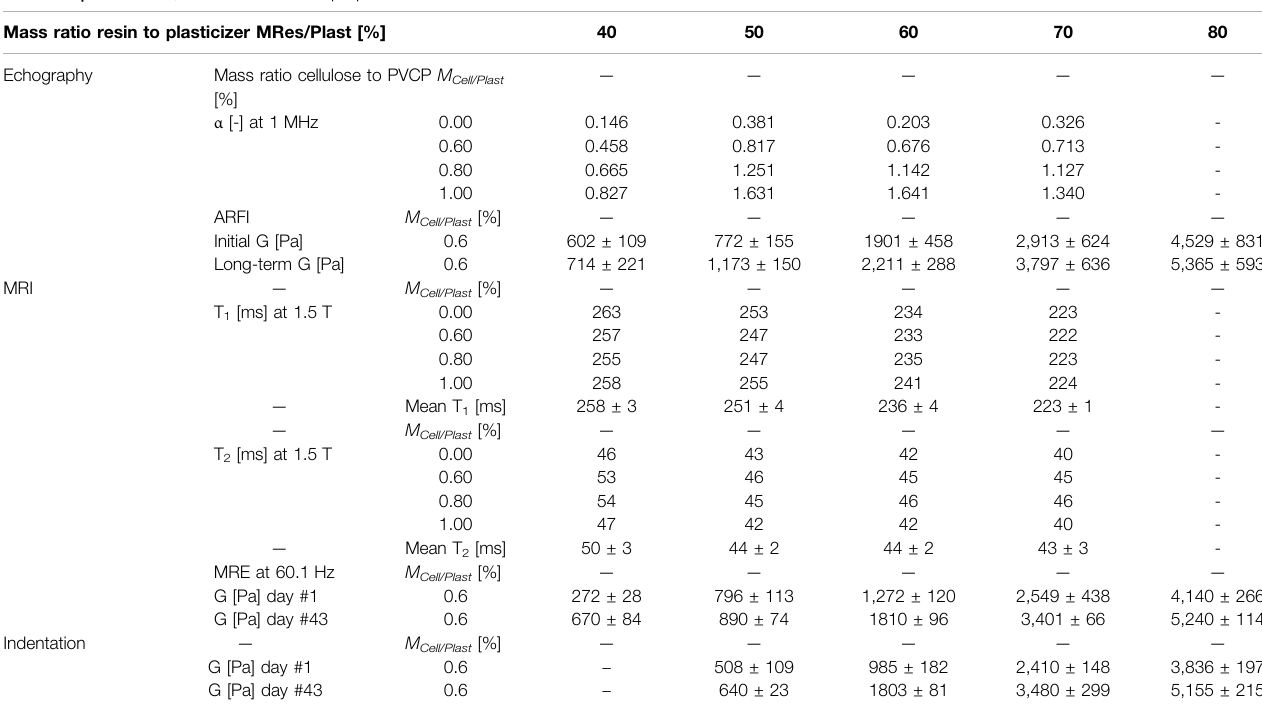
TABLE 1 | Mechanical, ultrasonic and MRI properties of the tested